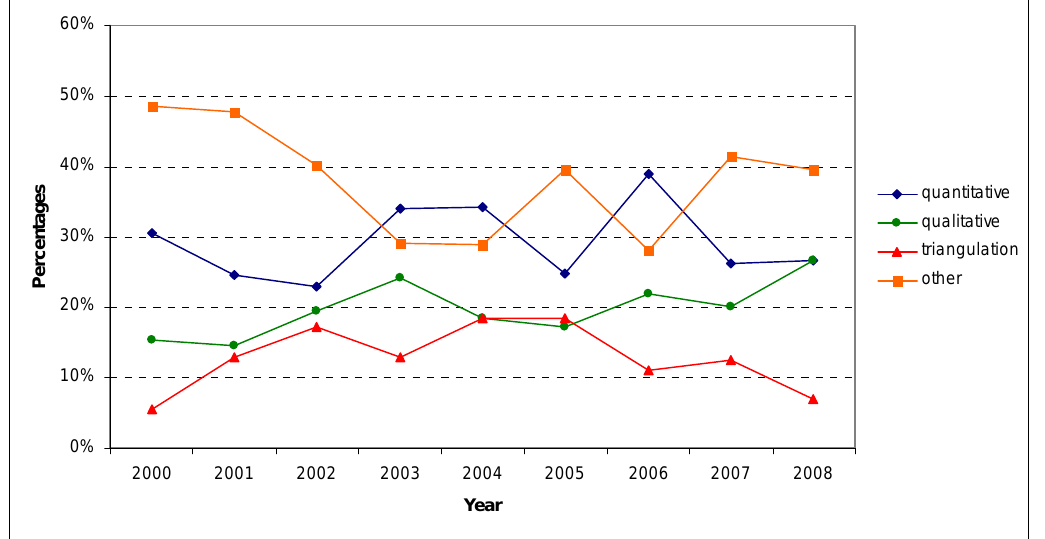
Figure 1 . Frequencies regarding methodological approaches in studies published between 2000 and 2008.